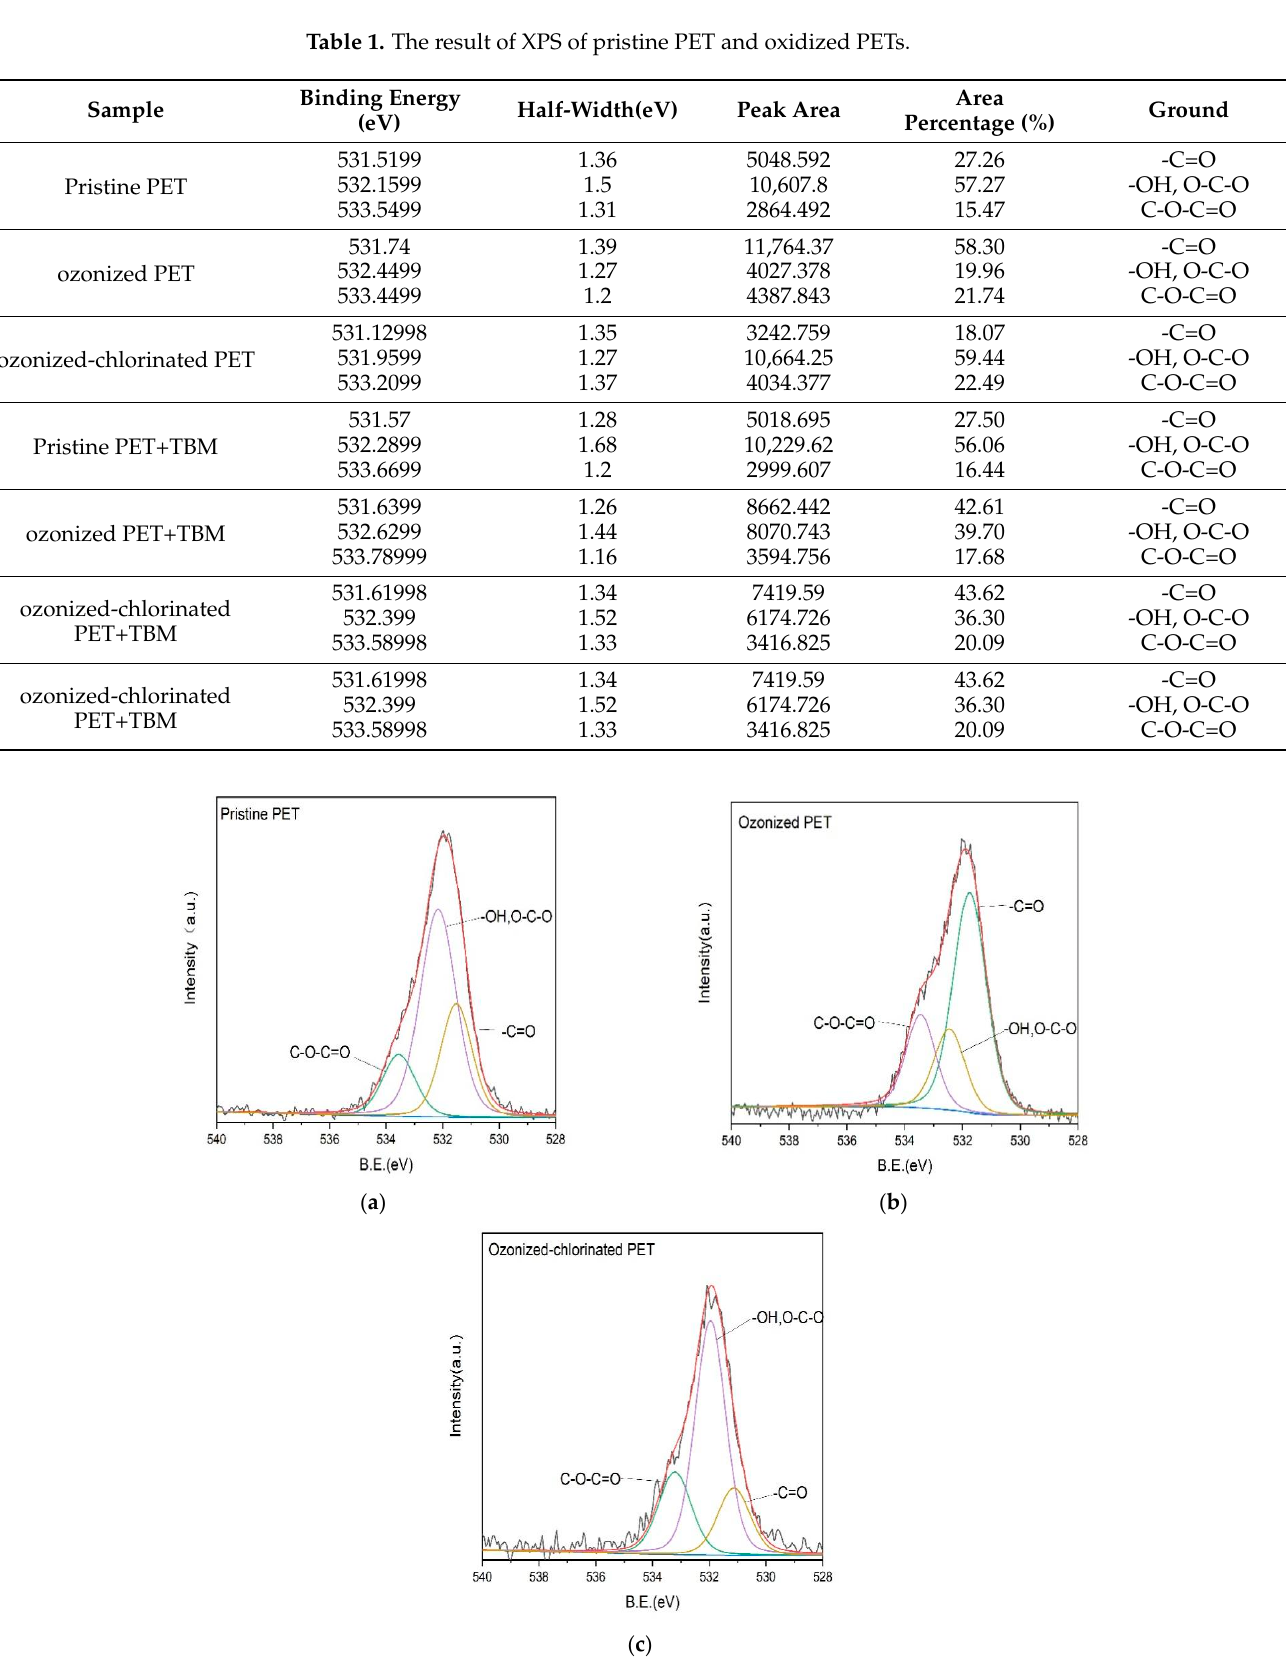
Figure 5. The result of XPS of ( a ) pristine PET, ( b ) ozonized PET and ( c ) ozonized − chlorinated PET before adsorption. Table 1. The result of XPS of pristine PET and oxidized PETs.